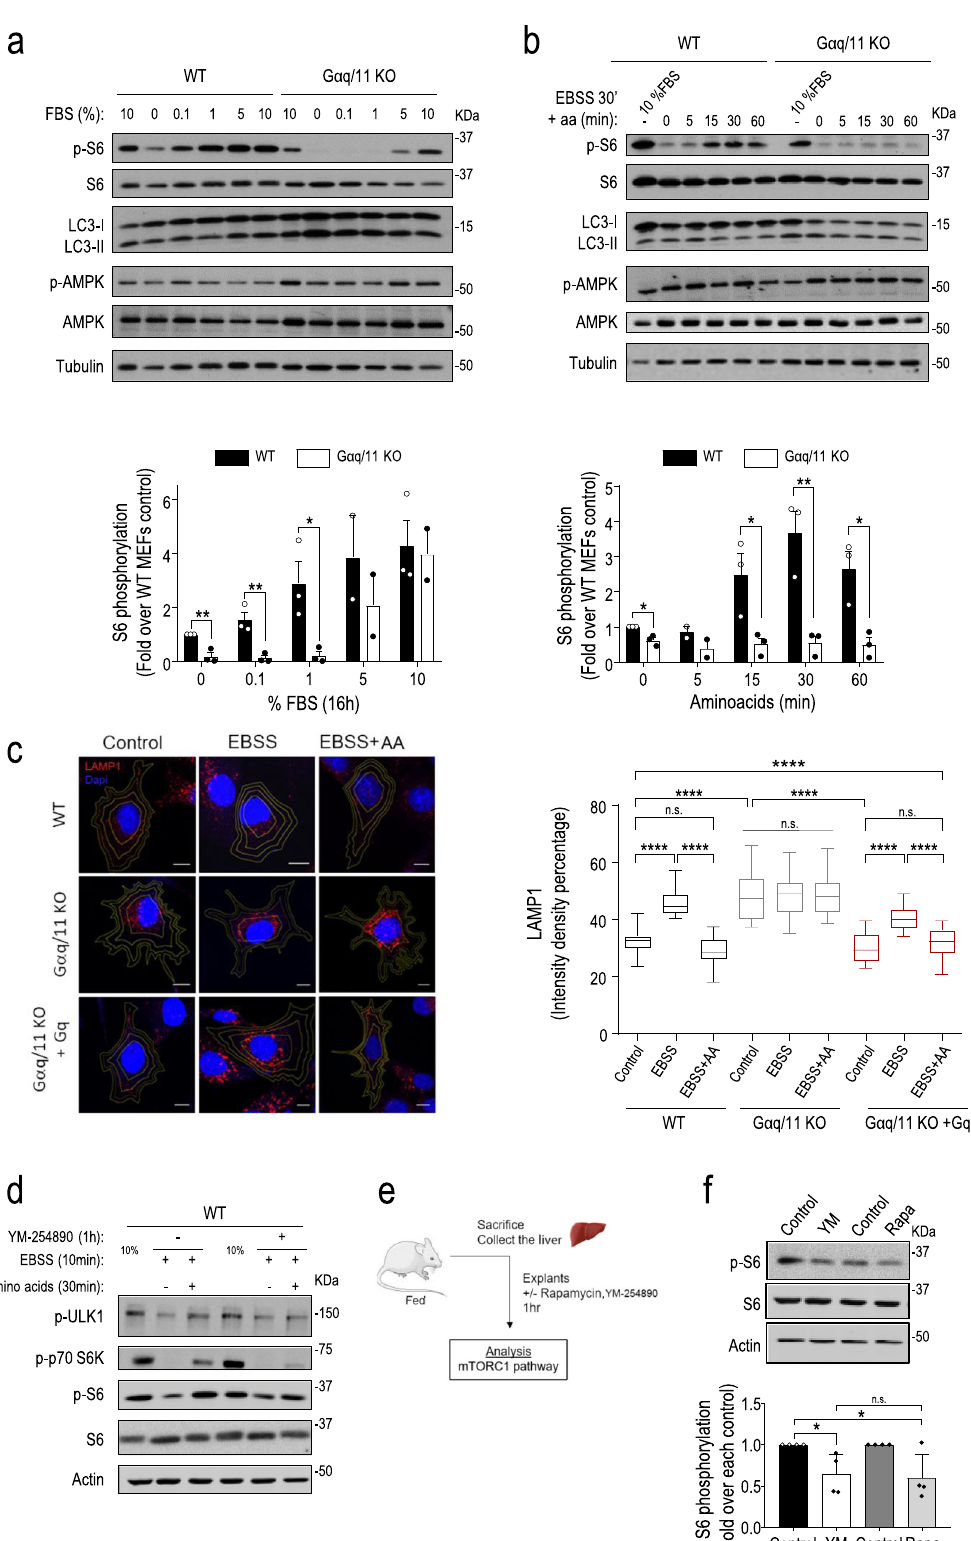
A novel acidic region in G α q responsible for its direct interaction with the PB1-containing protein Protein kinase C ζ (PKC ζ ) has been reported, and glutamic acid residues 234 and 245 proven to be critical for such interaction 29 . Remarkably, the stimulation of the mTORC1 pathway triggered by transient expression of G α q WT in low-serum conditions was not mimicked